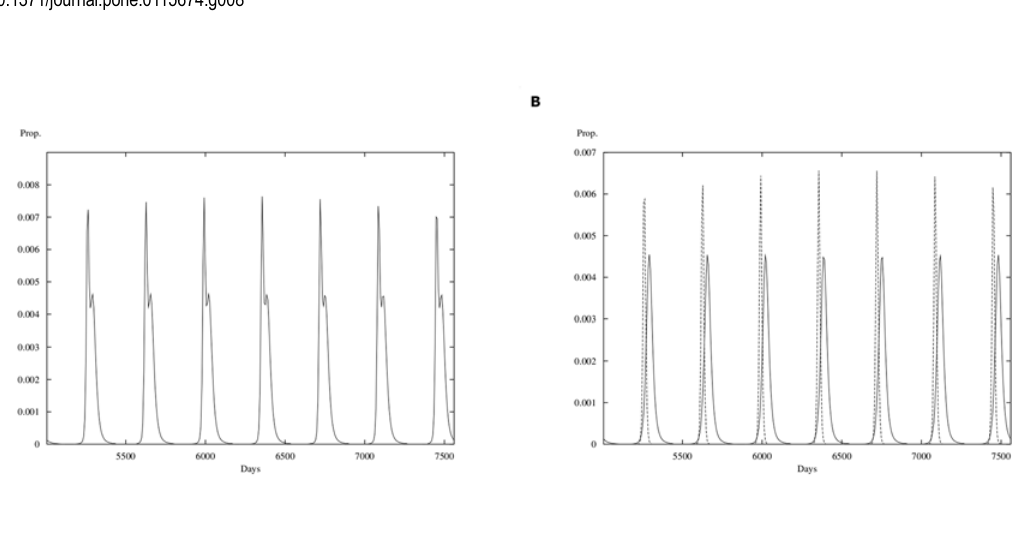
Fig 9. Simulations for the mathematical model. (A) Total cases (RSV plus influenza). (B) RSV cases are plotted with a continuous line; influenza cases plotted with a dashed line. Horizontal axis is time in days; vertical axis is proportion of the population. Plot is shown after a transient time of 5000 days where b θ = 0.0001 for R R σ = 1, b 1 = 0.9162 and 2 = 0.4566 and 01 = 1.83 and 02 =